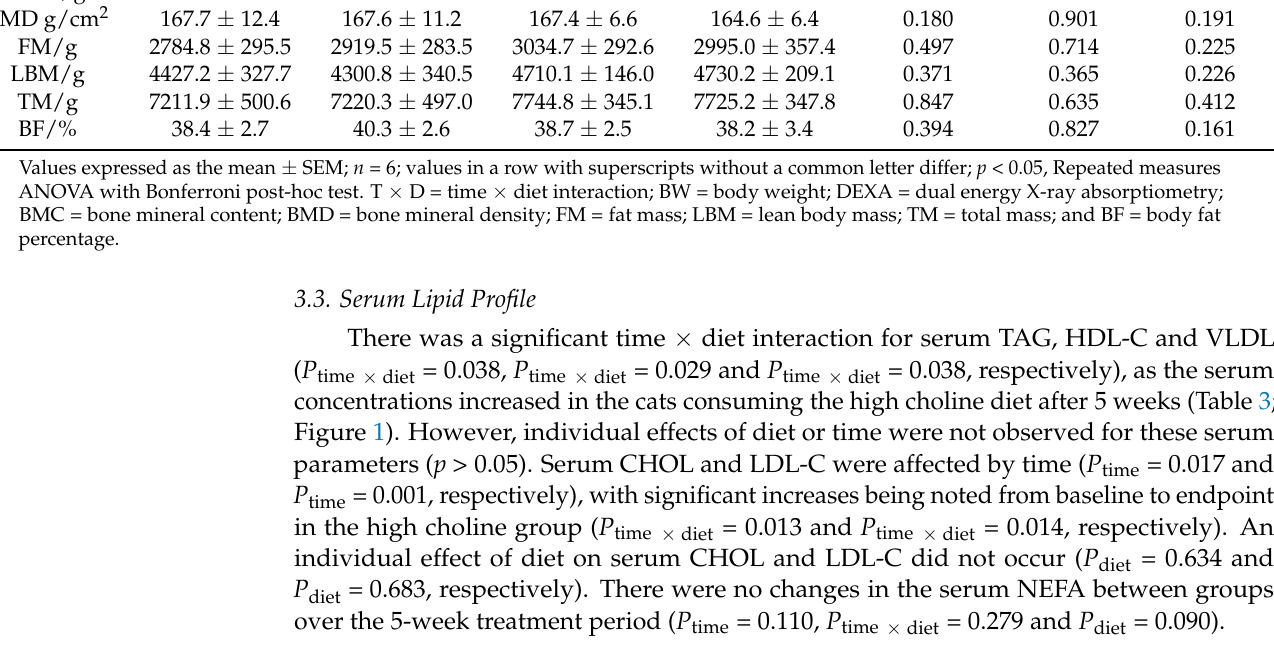
Values expressed as the mean ± SEM; n = 6; values in a row with superscripts without a common letter differ; p < 0.05, Repeated measures ANOVA with Bonferroni post-hoc test. T × D = time × diet interaction; BW = body weight; DEXA = dual energy X-ray absorptiometry; BMC = bone mineral content; BMD = bone mineral density; FM = fat mass; LBM = lean body mass; TM = total mass; and BF = body fat percentage.